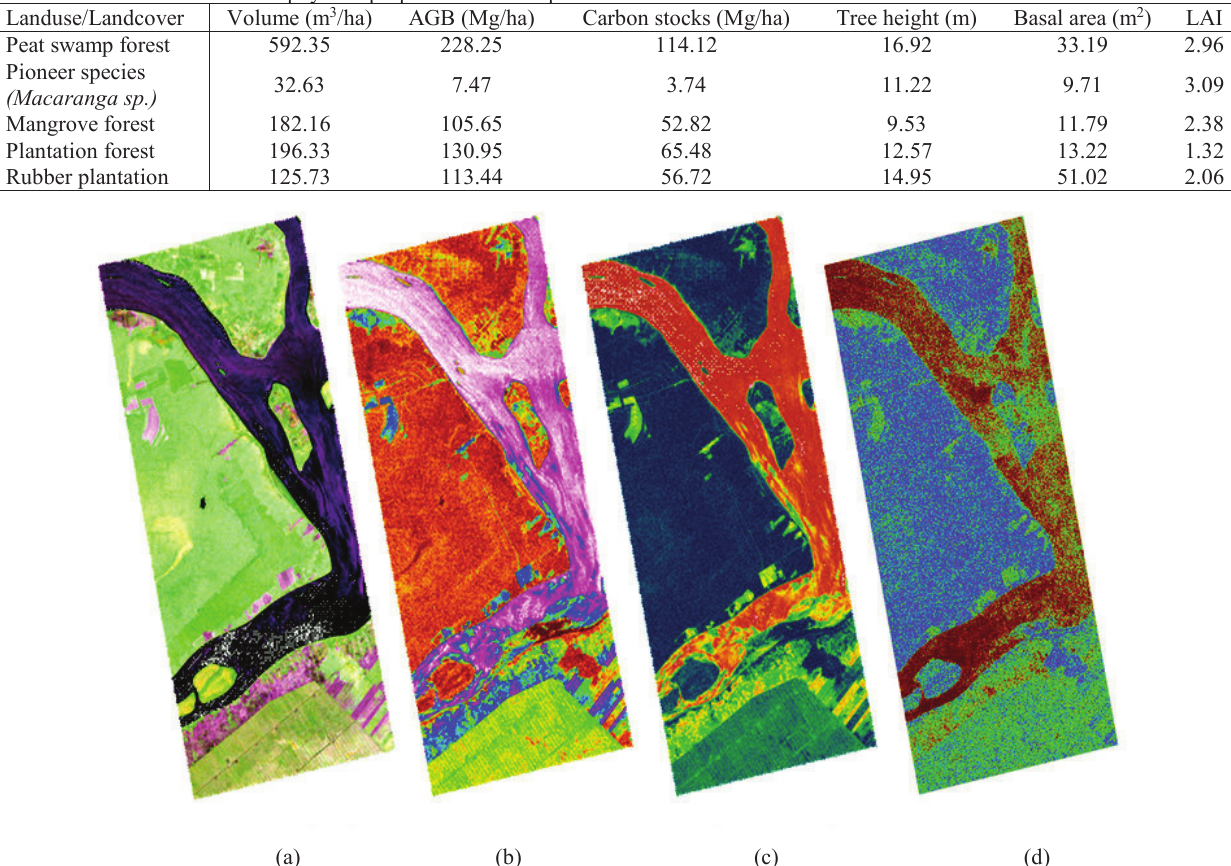
Table 1 Carbon stocks and biophysical properties over sampled areas